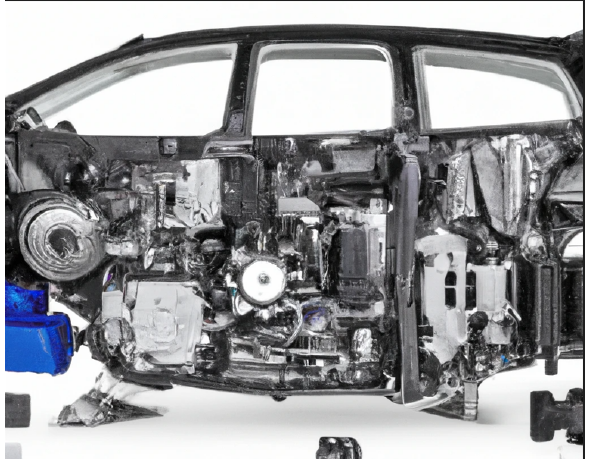
Figure 1. Illustration of the complexity of automotive assembly.